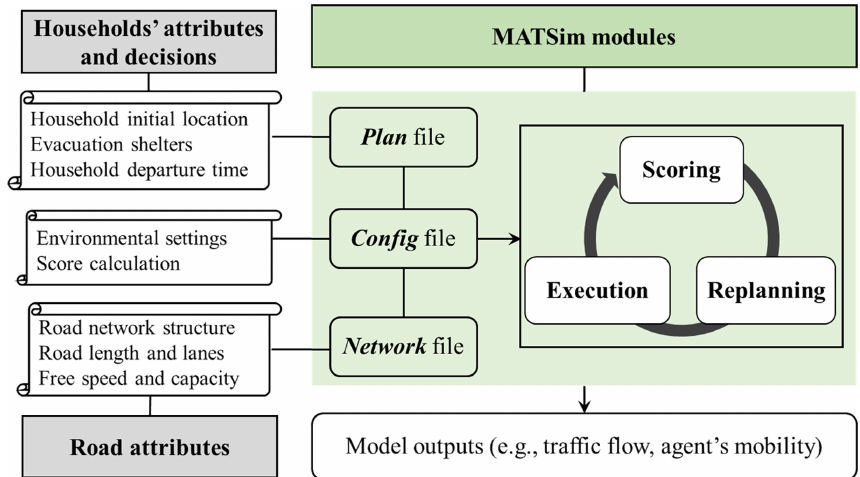
Figure 2. Inputs, modules, and processes of the MATSim